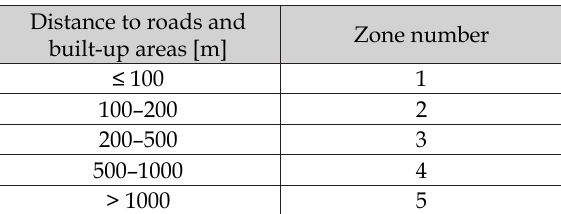
Table 2. Buffer zones applied to roads and built-up